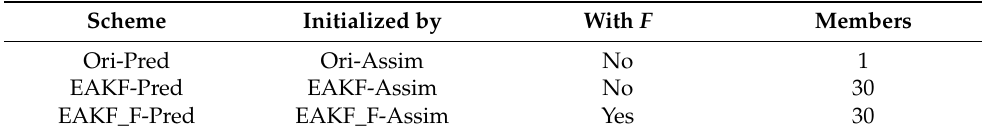
Table 2. Settings of the prediction